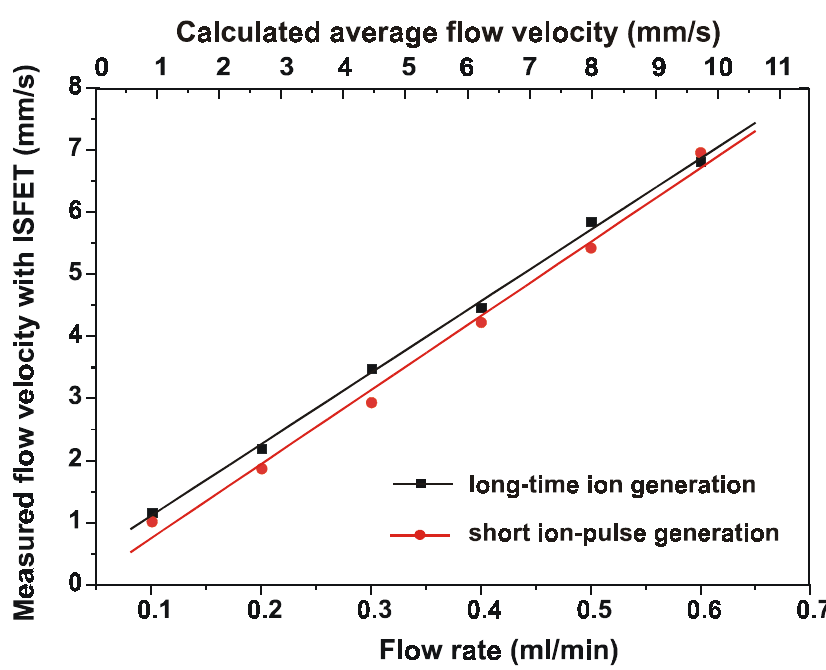
Figure 5. Calibration curves of the ISFET-array-based flow-velocity sensor for the two modes of ion generation.